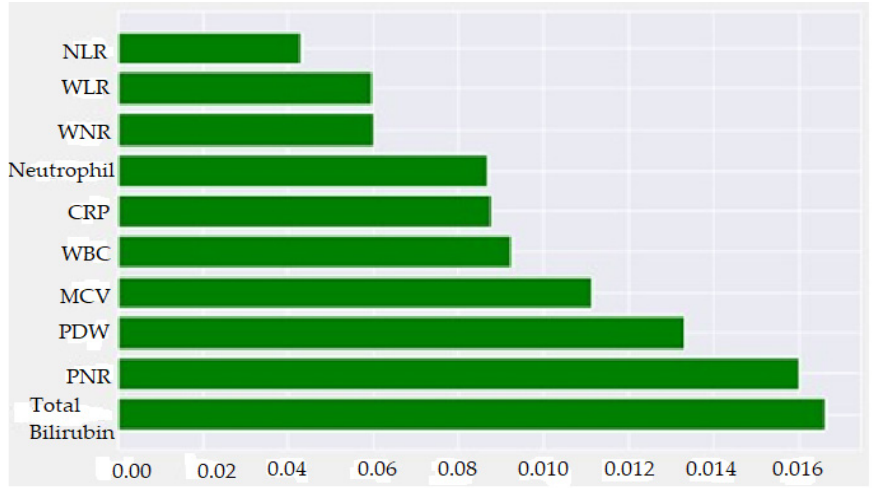
Figure 3. Graphical representation of the findings for the SHAP method for AAp. Table 2. Importance values of factors for classification of AAp.